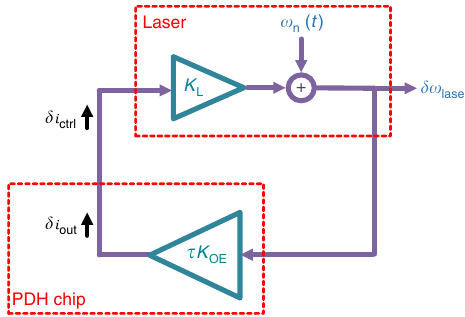
Fig. 5 Linearized Pound − Drever − Hall system. The block diagram of the linearized Pound − Drever − Hall (PDH) system is shown where the laser and the PDH system are linearized around the operating point. When the loop is open, the total laser frequency noise, δω laser , is equal to the laser intrinsic frequency noise, ω n ( t ). When the loop is closed, the PDH chip output current, δ i out , would be the same as the laser control current, δ i ctrl . In this case, the laser frequency noise is reduced by the loop gain, where the loop gain is de fi ned as the product of the PDH small signal frequency to output current conversion gain, τ K 0E , and the laser small signal current